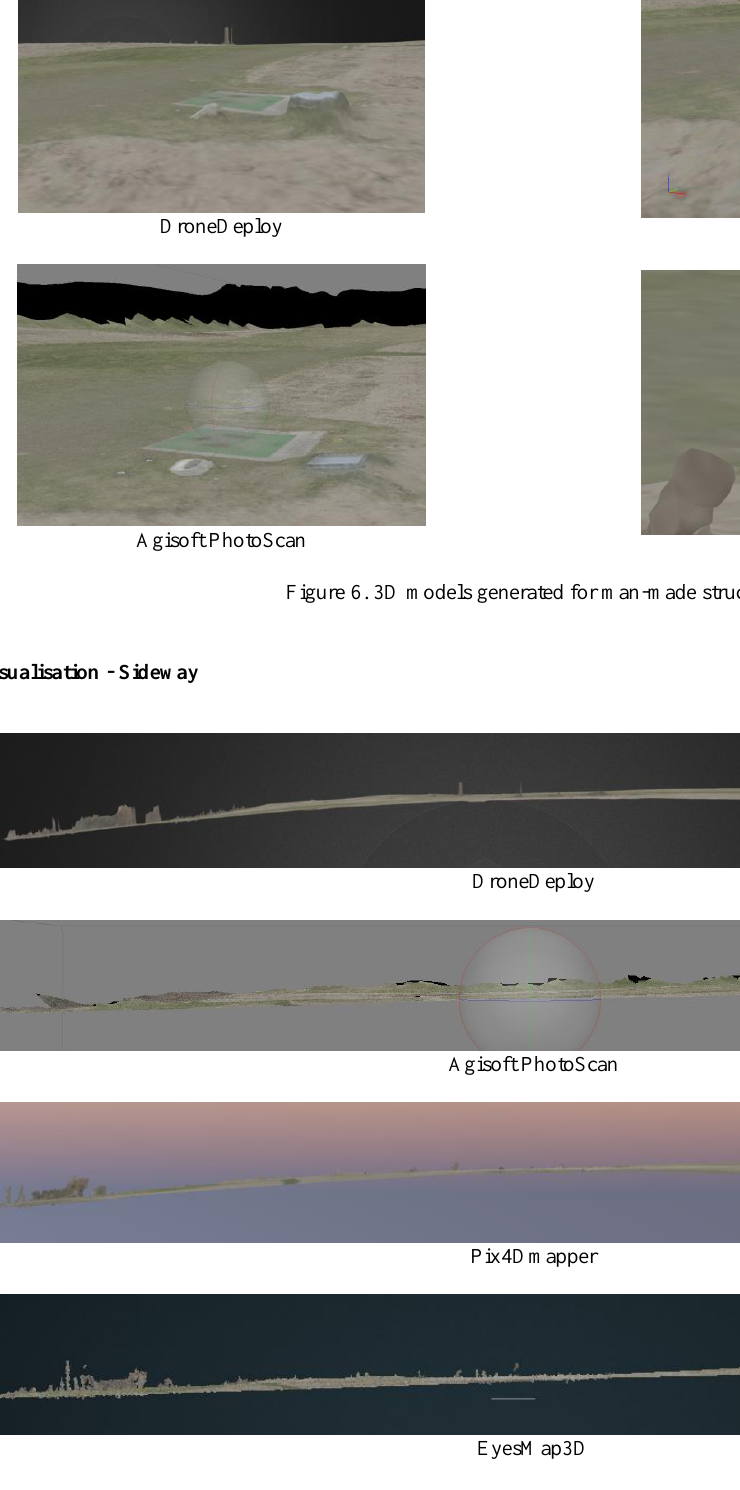
Figure 7. 3D models generated –